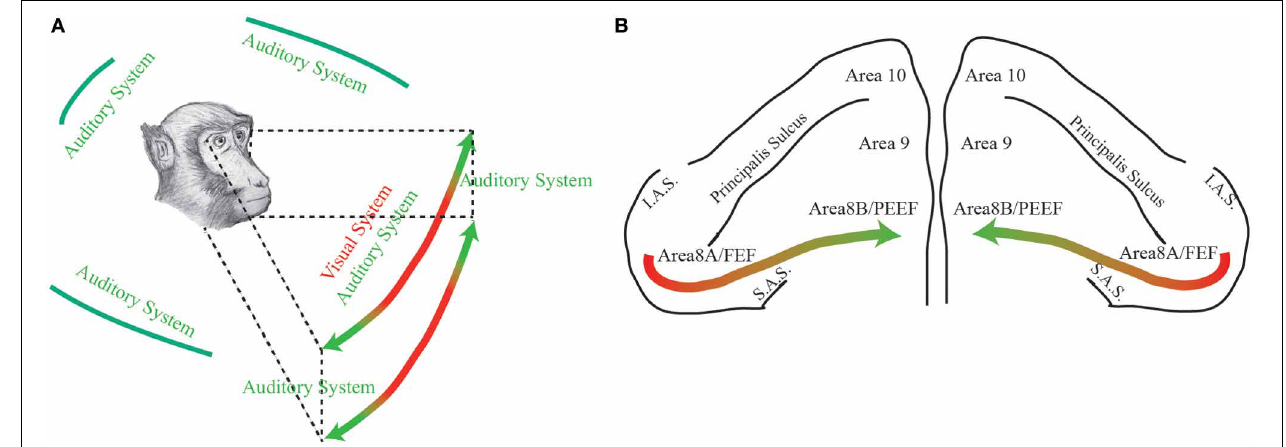
FIGURE 1 | (A) The figure represents the space detected by primates through two different sensory modalities: green, auditory modality; red, visual modality. (B) Dorsal view of the monkeys’ prefrontal pole. The colored